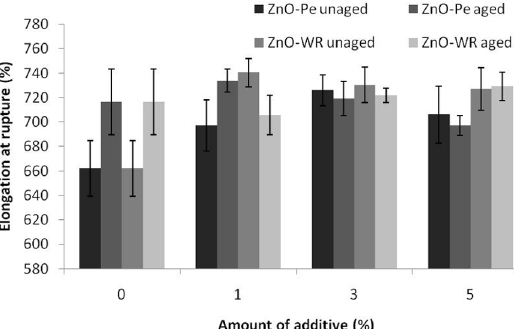
Figure 3. Variation in elongation at rupture of aged and unaged ZnO loaded TPE compounds. Error bars means ± SD of ten replicates. were not significant (Figure 2 and Figure 3). The same